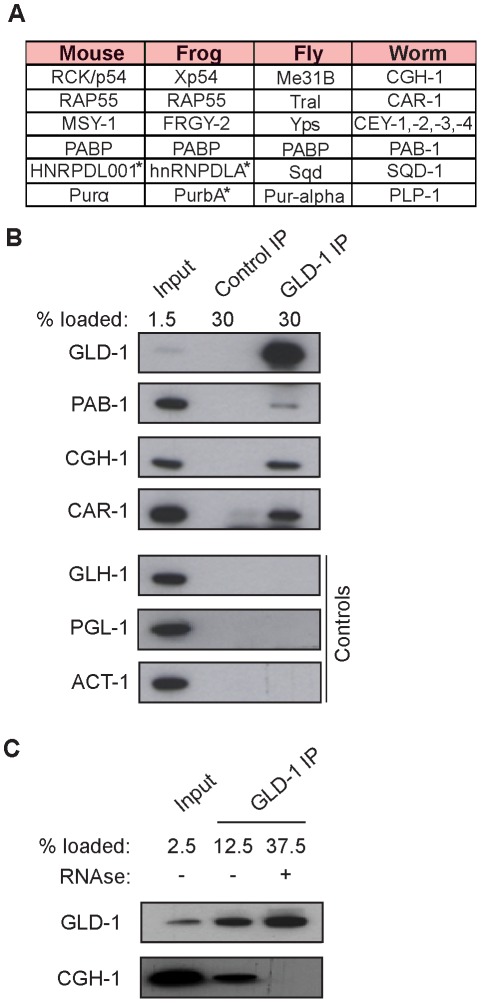
GLD-1 interacts with conserved components of RNA granules.(A) A table summarizing top GLD-1 interacting proteins and their counterparts in other species. Shown are GLD-1 co-precipitated proteins (identified by mass spectrometry) and their homologs. Proteins marked with asterisks are predicted based on available transcripts. (B) Confirmation of some interactions by western blot analysis of GLD-1 IPs. GLH-1/Vasa, PGL-1, and ACT-1/actin are negative controls. (C) The interaction between GLD-1 and CGH-1 depends on RNA. RNAse treatment of GLD-1 IPs prevents CGH-1 from co-immunoprecipitating with GLD-1.